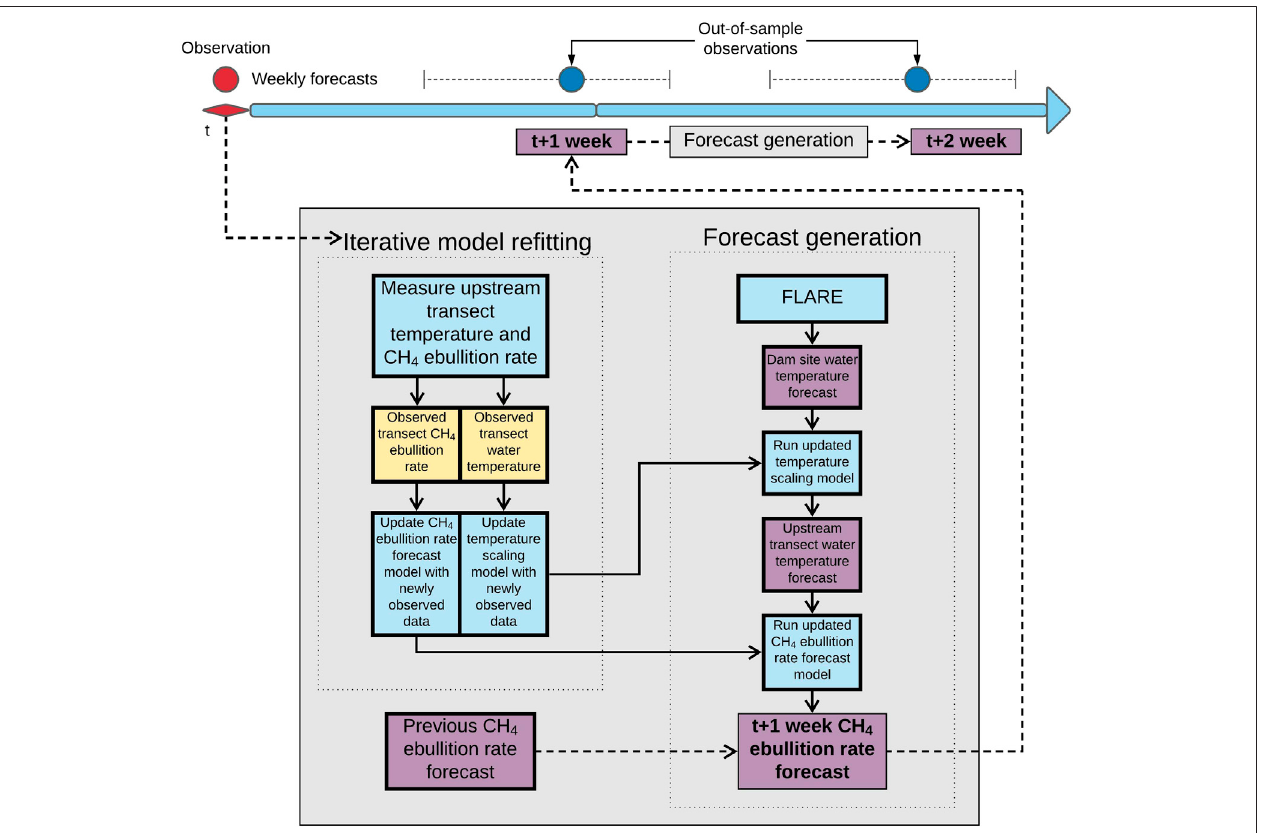
FIGURE 2 | Conceptual illustration of the forecast work fl ow using iterative model re fi tting that generates near-term, iterative CH 4 ebullition forecasts. The model re fi tting stage occurred at the time when new ebullition rates were manually collected from the reservoir. In the shaded part of the fi gure, the blue boxes represent processes, and the yellow and purple boxes represent the data products that resulted from each process. The yellow boxes are manually-collected data products that were used to update the forecast model and the purple boxes represent forecasted data products.